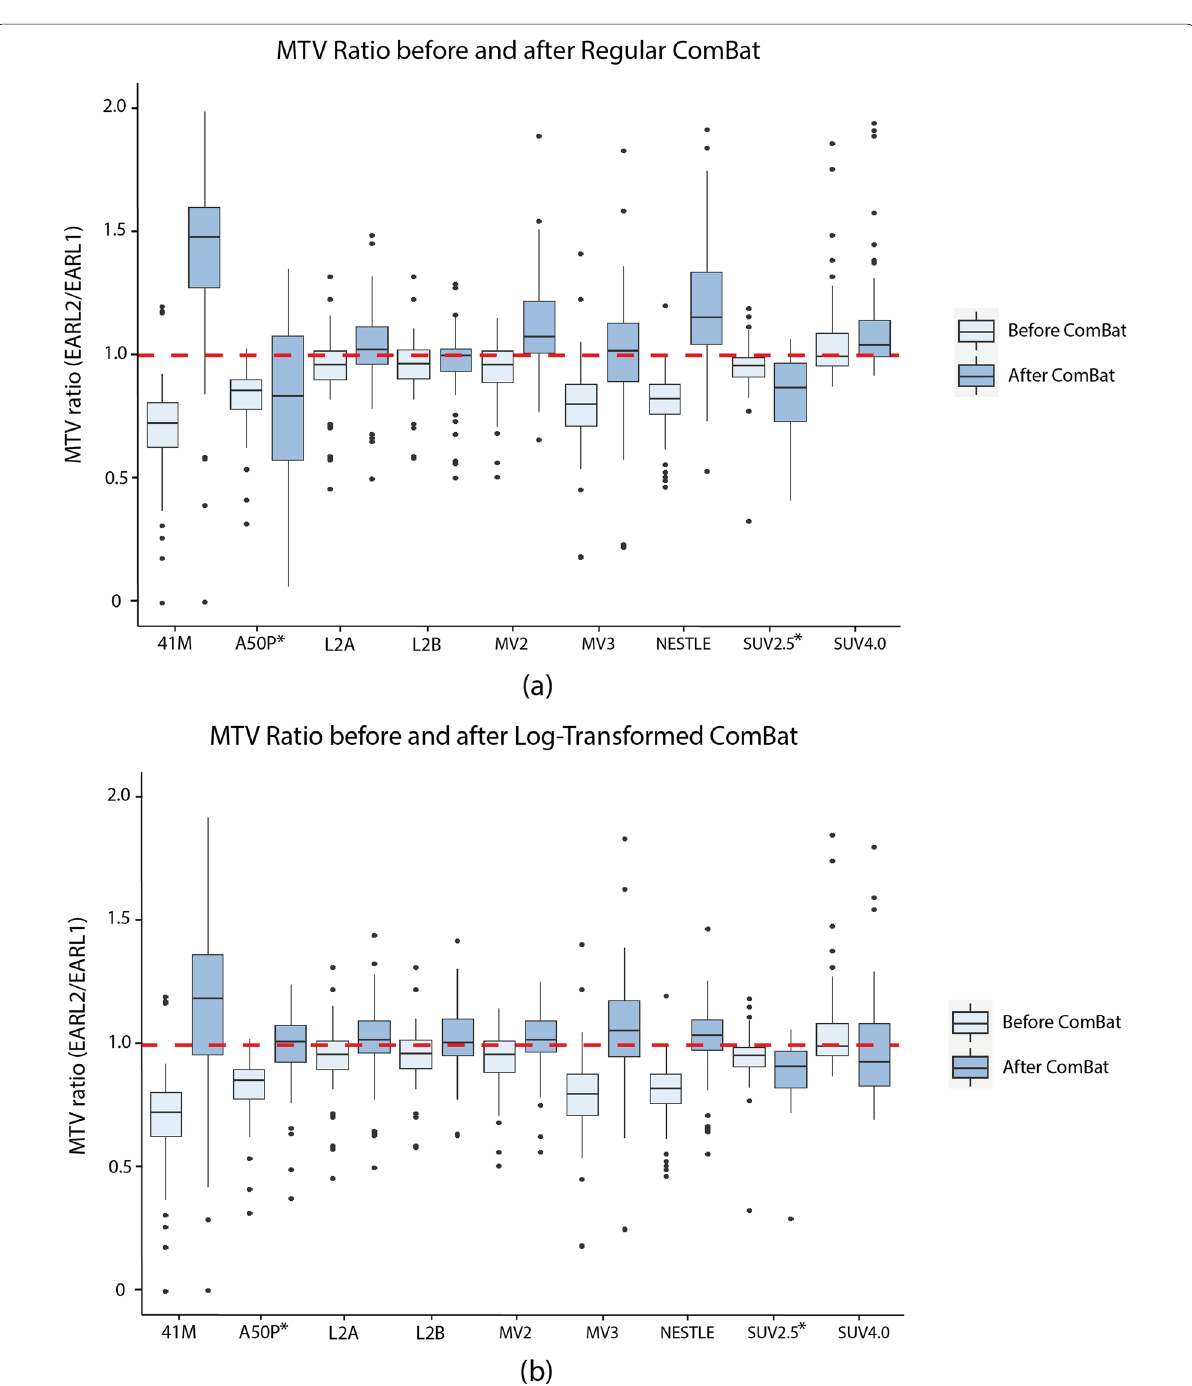
Fig. 3 MTV ratio across 9 segmentation methods. MTV ratio calculated by comparing MTVs of EARL2 to those of EARL1, with EARL1 as the denominator for a particular segmentation method: 41M, A50P, L2A, L2B, MV2, MV3, NESTLE, SUV2.5 or SUV4.0. For each segmentation method, 2 boxplots are shown. The light blue boxplot represents data without ComBat harmonization, while the dark blue boxplot is obtained after ComBat harmonization. MTV ratio equal to 1 indicates a perfect alignment between reconstructions. a MTV ratio before and after ComBat using non-transformed distribution (Regular ComBat) b MTV ratio before and after ComBat using log-transformed distribution (Log-transformed